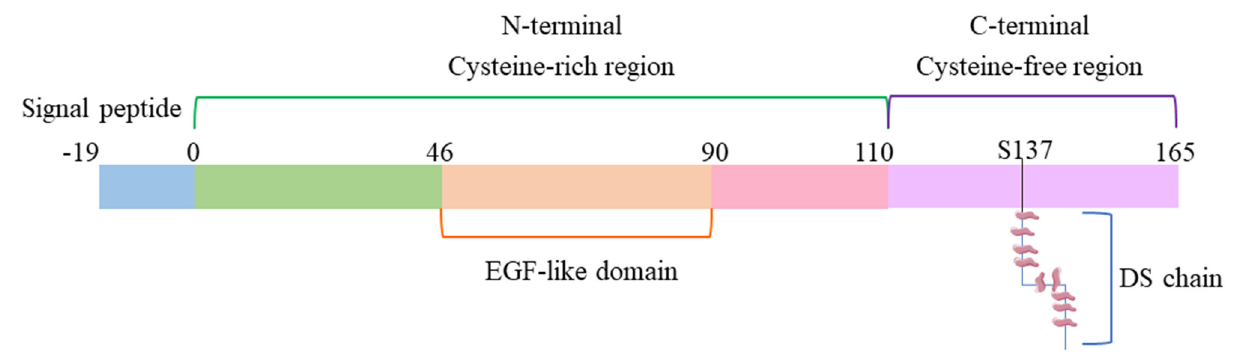
on the expression of endocan genes induced by TNF- α